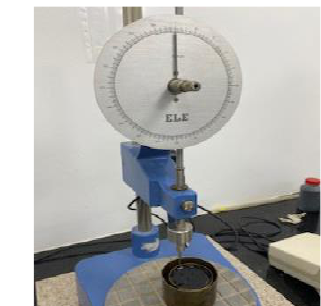
Figure 10. Putting the Sample (without Polymer) in the penetration